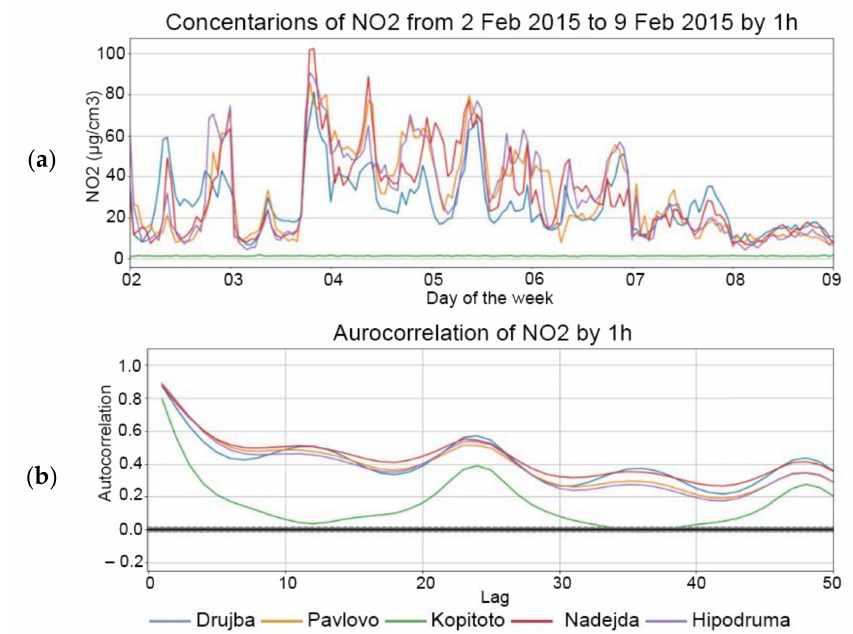
Figure 5. The signal for the different stations corresponding to NO 2 measured by 1 h ( a ) and the corresponding autocorrelation ( b ).